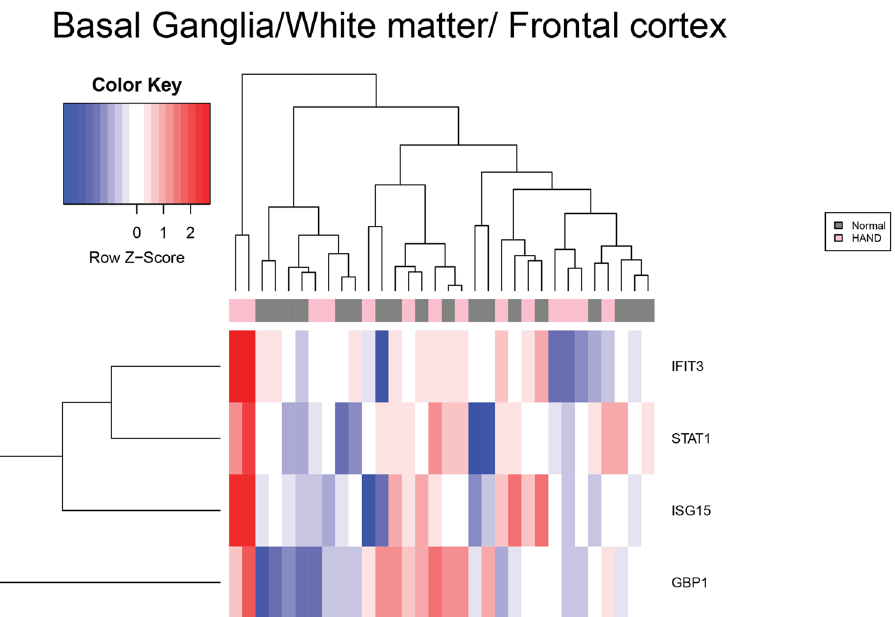
Figure 1. Heatmap of mRNA expression in HAND patients. This figure represents the expression value of mRNA from HAND and controls patients’ brains in GSE35864. The data were normalized using the GCRMA Bioconductor package. The mRNA expression of IFIT3 , STAT1, ISG15, and GBP1 was chosen by comparing independent SAM results and identifying common markers that were shared between pathologies. The color key represents the Z score the blue represents underexpression and red represents overexpression. These mRNA transcripts were found to be under-expressed in patients with HAD compared to HIV-1